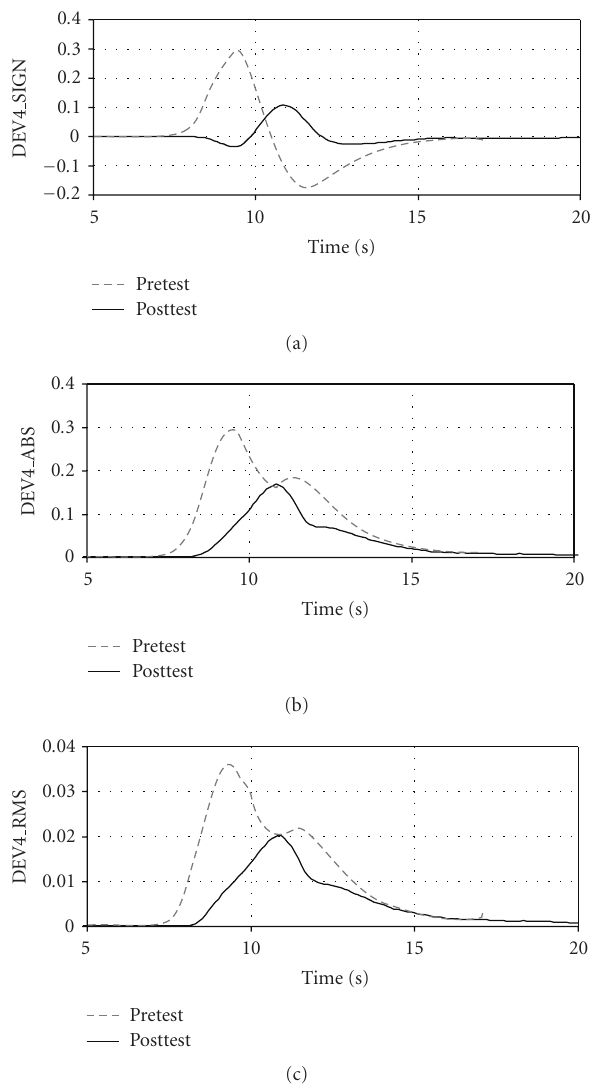
Figure 13: Core-averaged deviations (DEV4): sign, abs. value, root mean